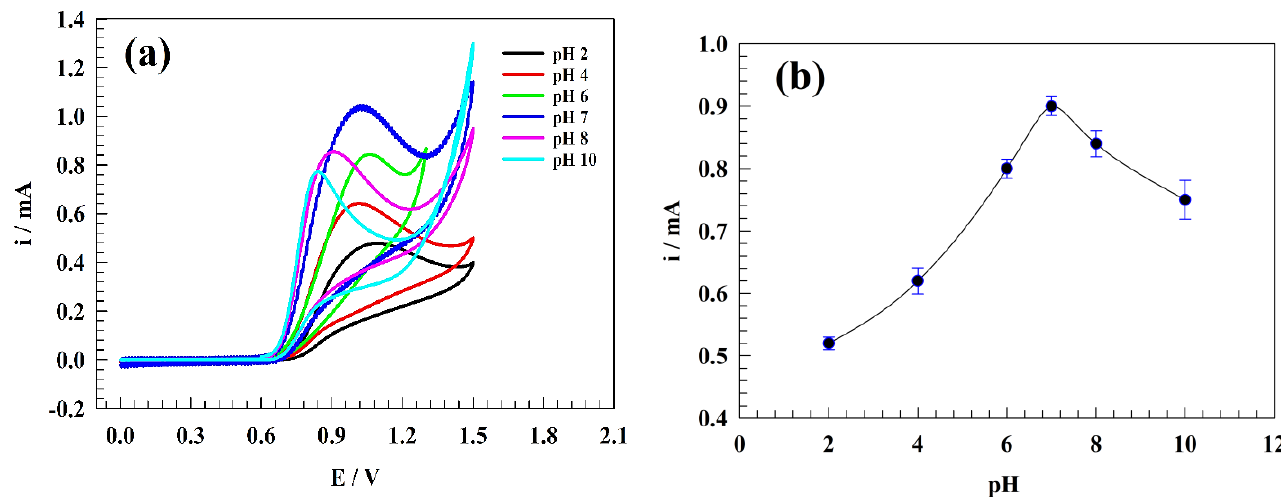
Figure 6. ( a ) CVs of the GC/PANI/NiOnF in 0.5 mM nitrite solution at different pH values. ( b ) The dependence of oxidation current on the pH of the